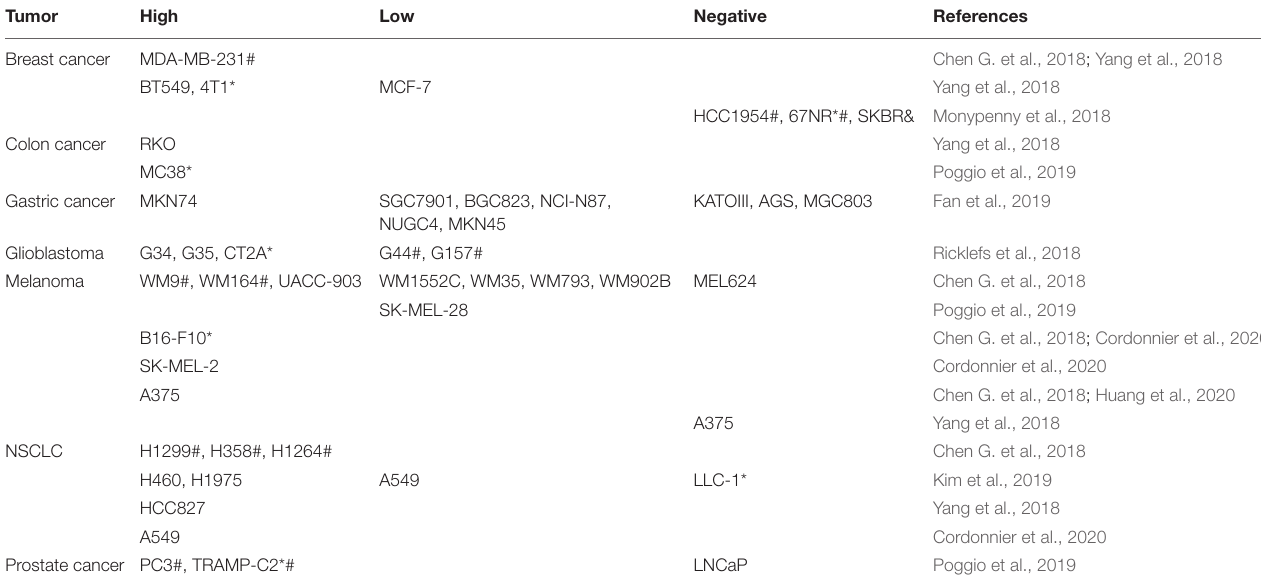
TABLE 1 | Expression of ExoPD-L1 secreted by human and mouse tumor cell lines. Tumor High